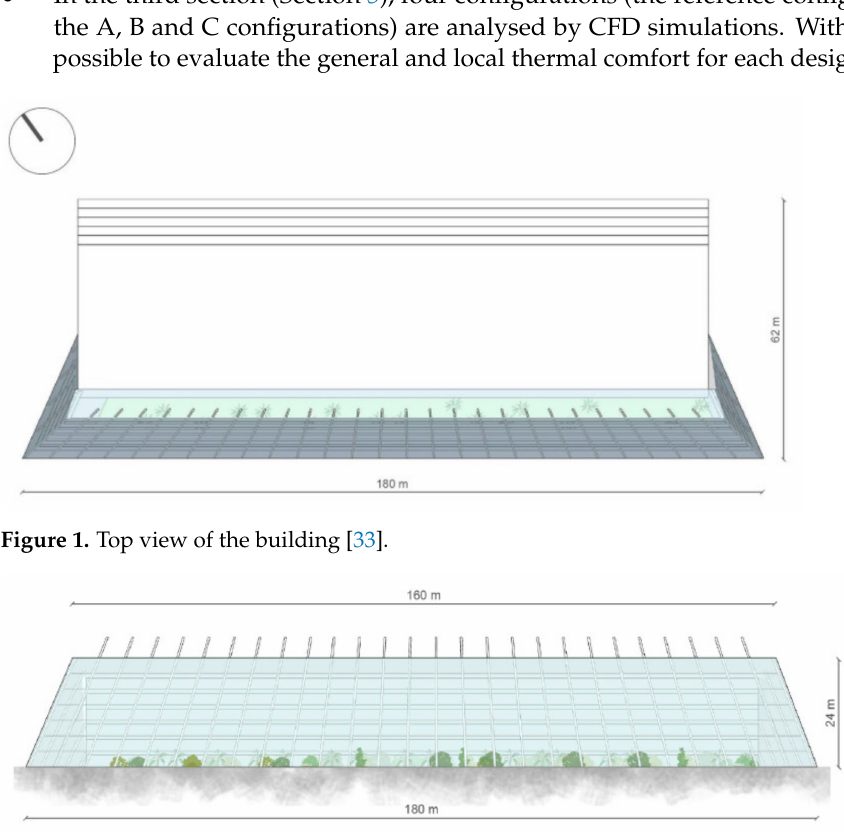
Figure 2. Frontal elevation (south-east side)